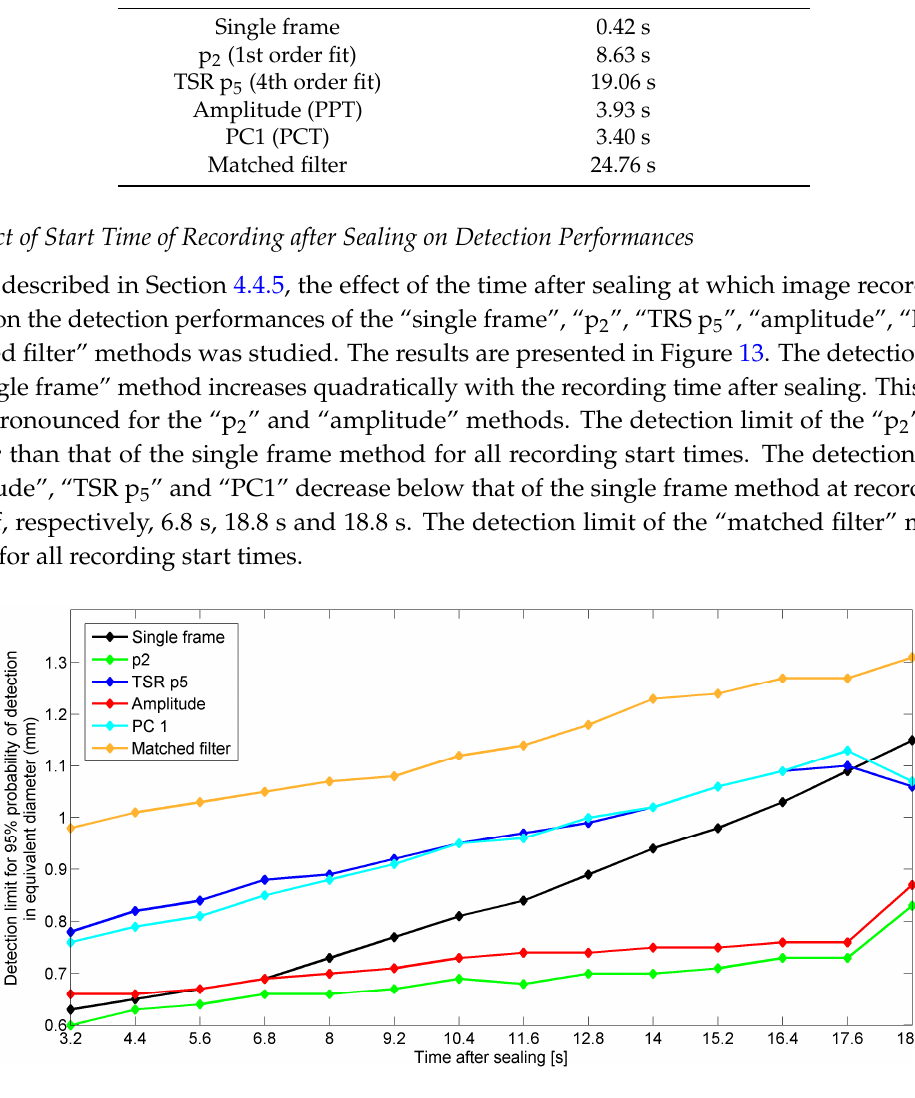
Figure 13. Detection limit for 95% probability of detection as a function of the time after sealing at which recording was started.